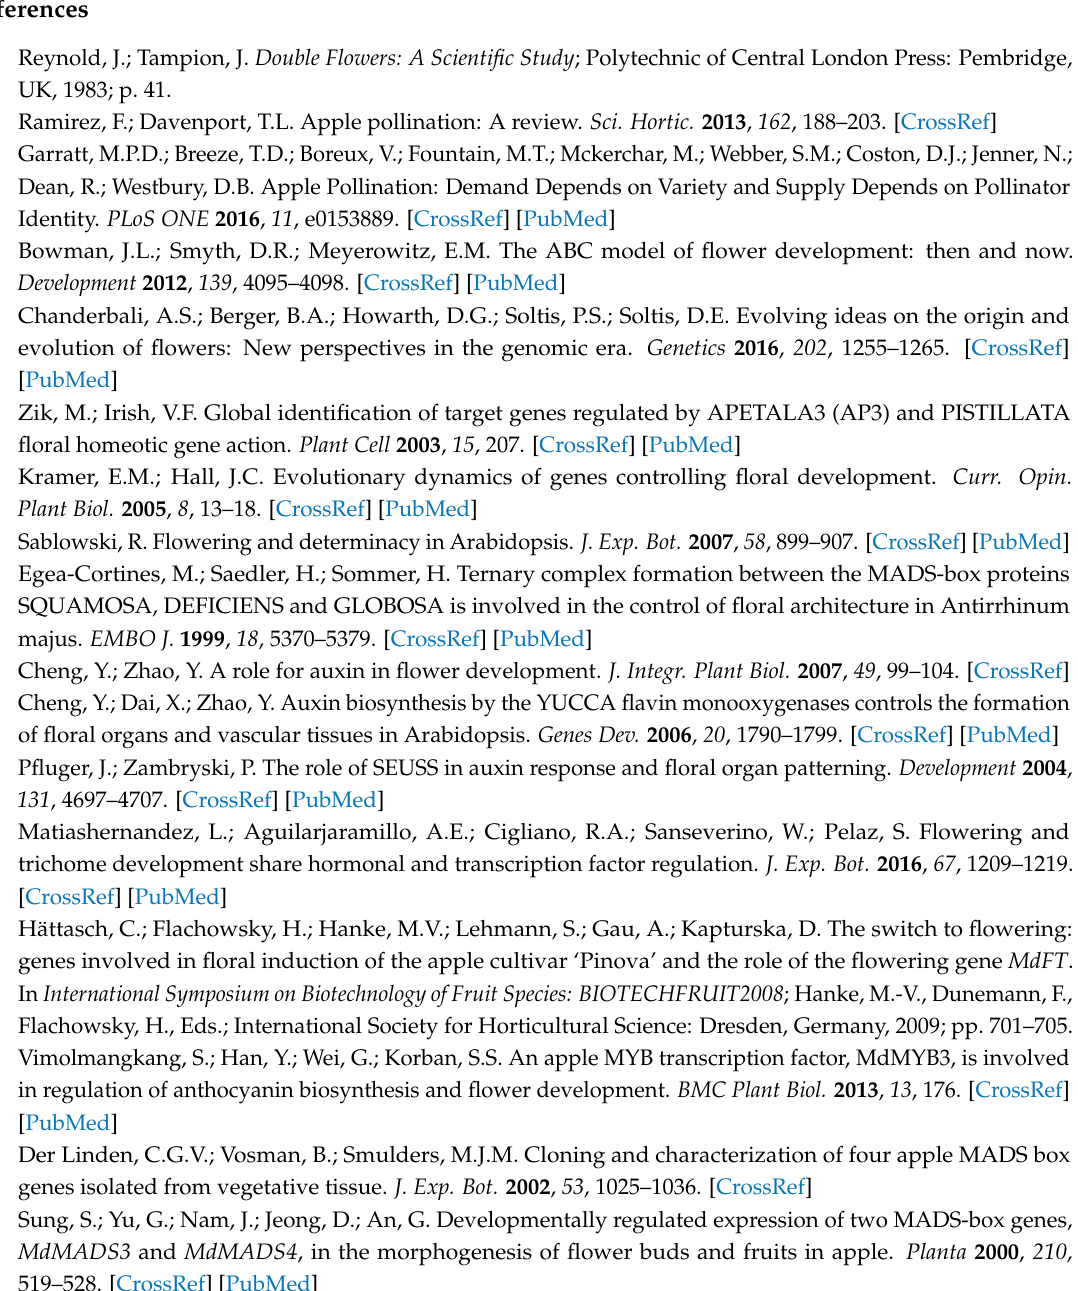
key genes involved in double flowering, Table S10: Cytoscape gene aetwork analysis for key genes involved in double flowering, Table S11: details of genes selected for qRT-PCR assay, Table S12: gene expression values from qPCR, Figure S1: expression trends of differentially expressed MADS-box transcriptional factors regulating double flowering, Figure S2: Correlation Analysis of qRT-PCR data and RNA-seq data. Availability of Supporting Data: All the original RNA-Seq data has been submitted to the NCBI Sequence Read Archive under the accession number of